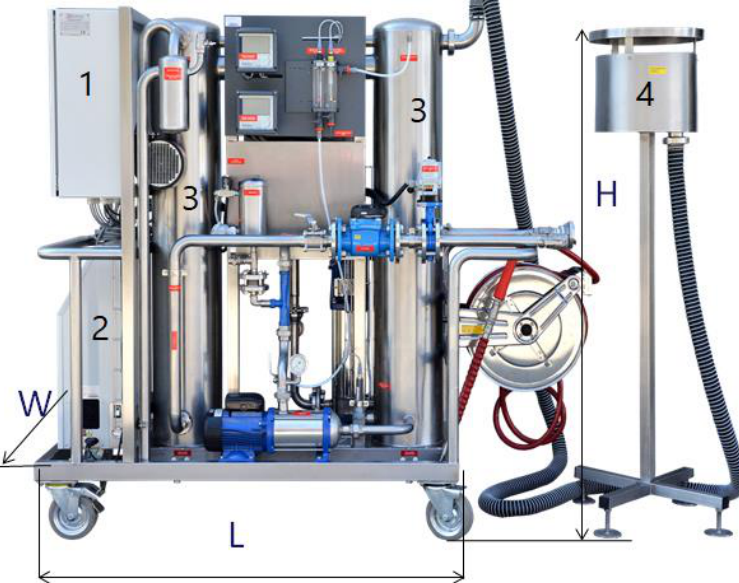
Figure 2. Mobile ozone rinse and disinfection system, where H = 1.7 m, L = 2 m, W = 0.6 m and maximal ozone production = 80 g/h: (1) pulse power supply; (2) oxygen and ozone generator; (3) contact columns for the production of highly ozonated water; (4) vent system with residual ozone destructor [16].